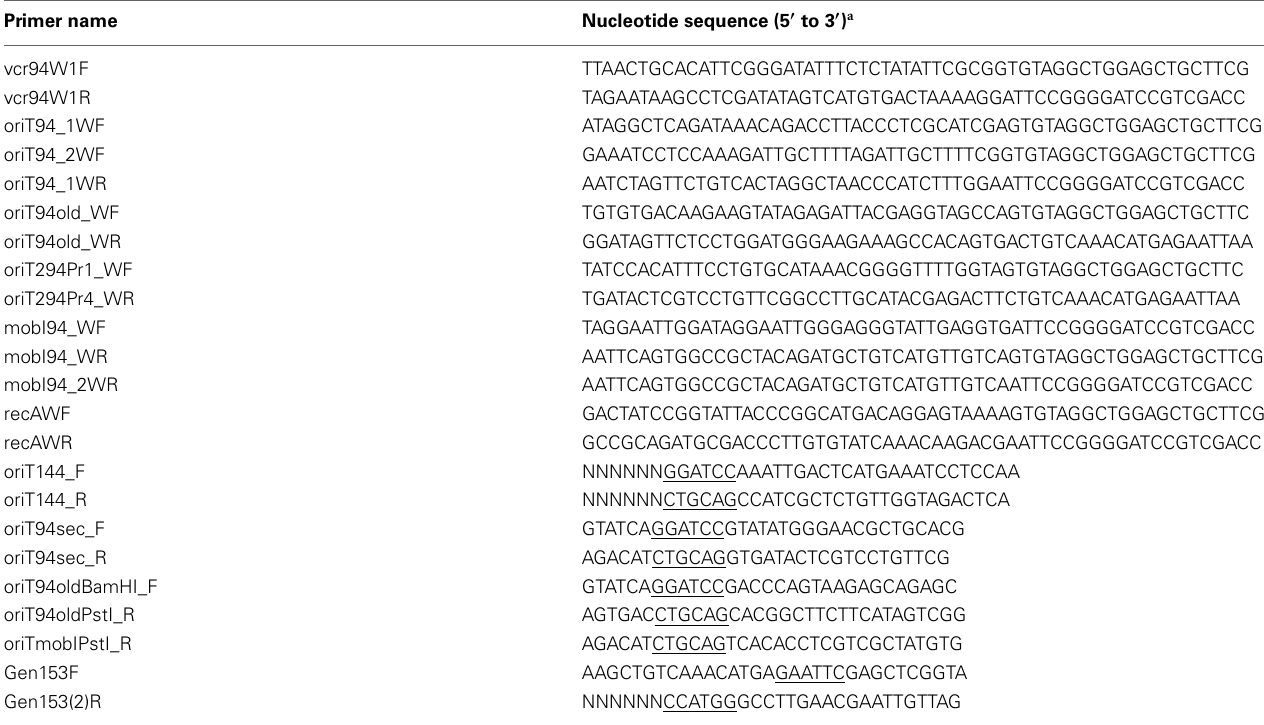
Table 2 | DNA sequences of oligonucleotides used in this